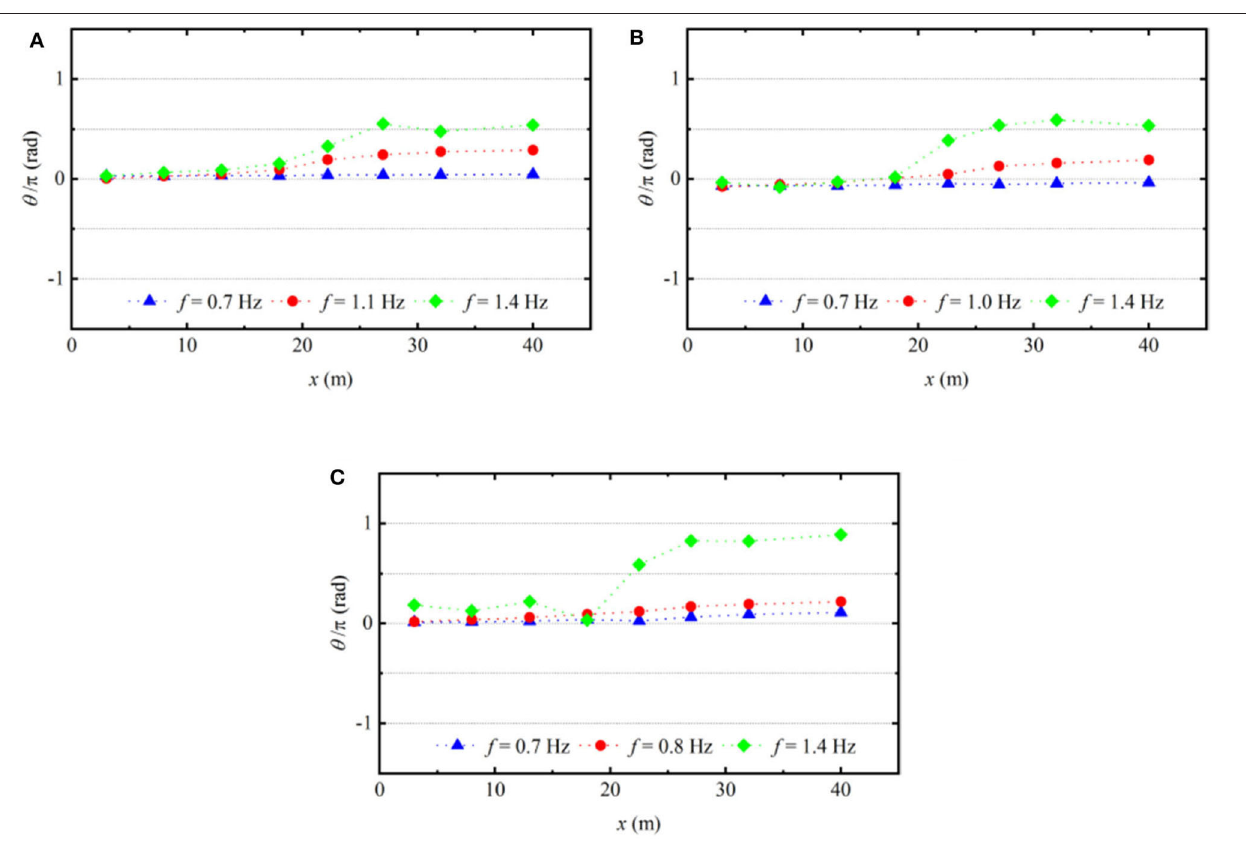
FIGURE 11 | The phase lag of the focused double wave groups relative to the linear superposition of the corresponding single wave group for selected frequencies along the wave flume. (A) Case 1_AB, (B) Case 2_AB, (C) Case